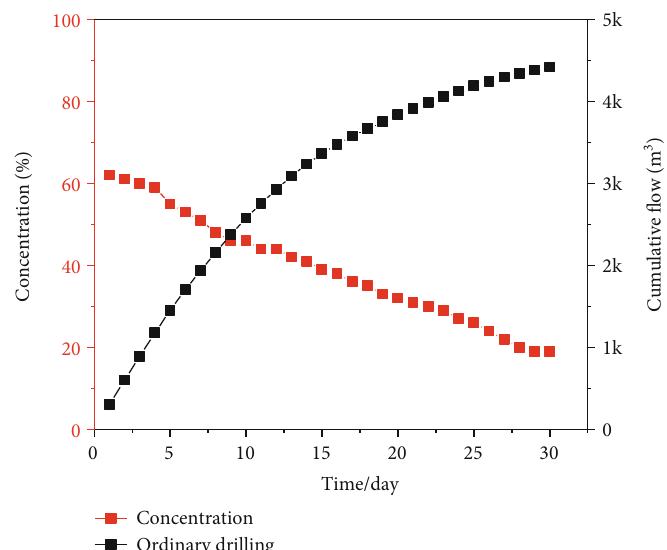
Figure 10: Change trend graph of gas drainage concentration and cumulative gas drainage scalar over time for six unreamed conventional boreholes for 30 consecutive days.